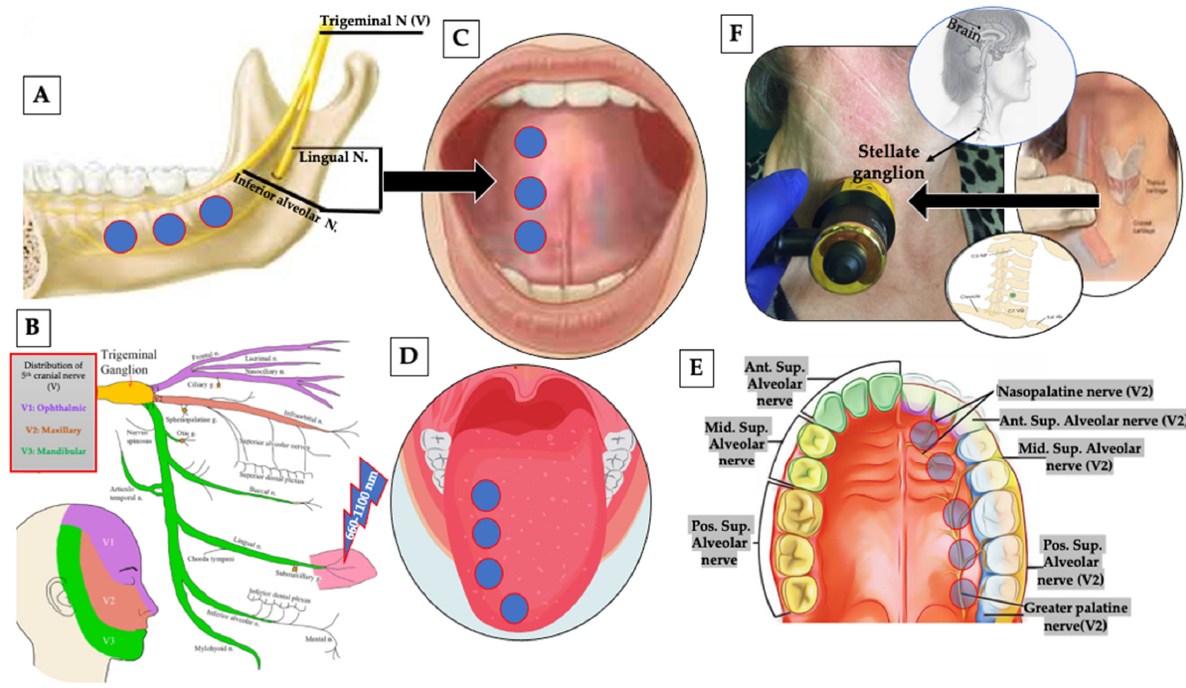
Figure 10. ( A–F ). Schematic representation of the proposed suggested number and allocations of the trigger points for PBM irradiation in unilateral BMS management. They are based on evidence derived from literature and expert opinion and are intended only to provide clinical guidance and serve as a starting point for extensive research. The blue circle represents the trigger points allocations and their number for unilateral symptoms. In case of bilateral symptoms, the same number of trigger points applies on both sides. As shown in ( A ), the allocation of the trigger points along the distribution of the lingual nerve (N), chorda tympani (branch of the facial N.) and inferior alveolar N, where the rationale number of the trigger points along the distribution of each nerve is three, depending on the diameter of the beam. As shown in ( B ), the trigeminal ganglion where V3 branches [ophthalmic (V1), Maxillary (V2), mandibular (V3)] emerge and their associated innervations. Irradiation of the ventral ( C ) dorsal ( D ) surfaces of tongue with wavelengths between 660–110 nm. As shown in ( E ), the hard and soft palate and their innervations as well the distribution of the trigger points along the distribution of the associated nerves. With regards the upper buccal mucosa of anterior, middle and posterior teeth (target areas), the allocation of the trigger points along the distribution of the nerves for their respected areas ( E ). As shown in ( F ), the extraoral approach of irradiation targets the stellate ganglion to reduce the abnormally increased sympathetic activities. Additionally, it illustrated in ( F ) the stellate ganglion landmark technique: The patient sits in a supine position with slight extension of the neck. The head is turned to the opposite side, applying the laser or LED probe on the meeting point of the clavicle with sternocleidomastoid muscle. List of the abbreviations are listed in Supplementary File